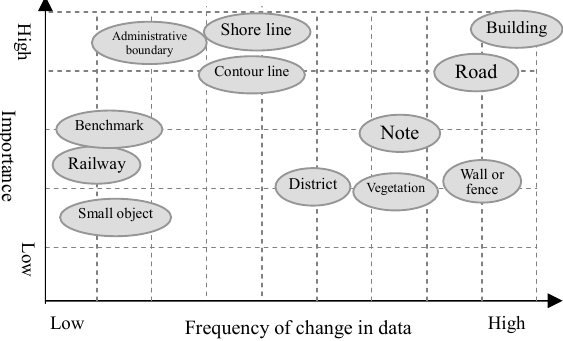
Figure 2. Distribution of planimetric features by importance and frequency of change in data